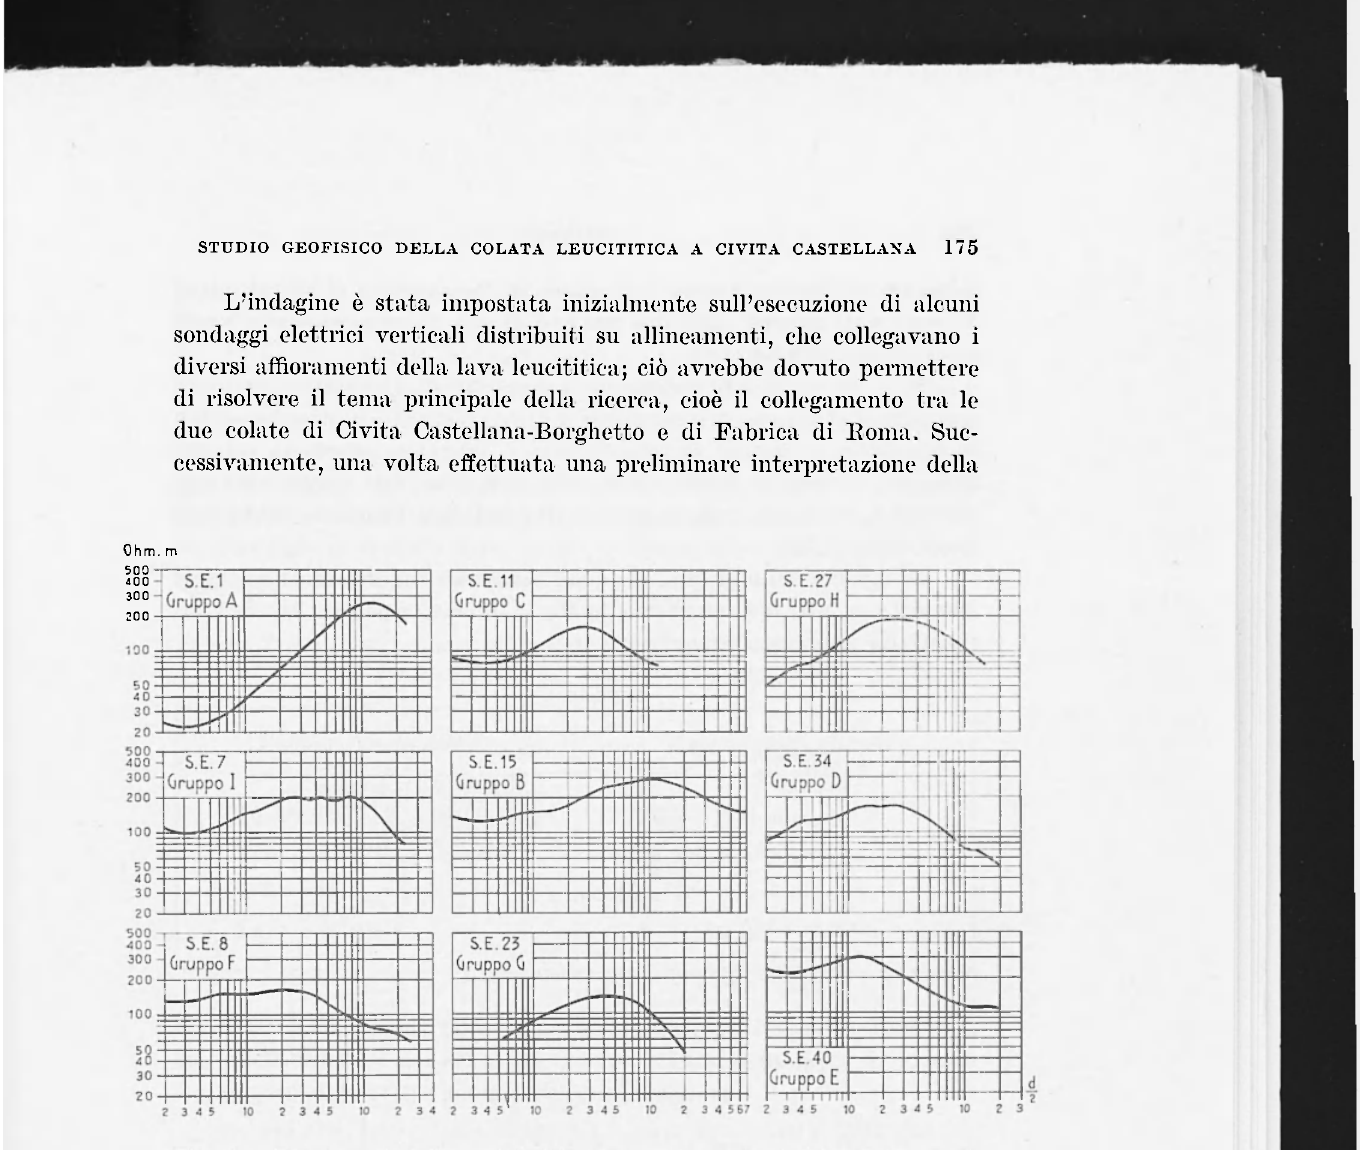
Fig. 2 - Diagrammi delle resistività, apparenti caratteristiche dei gruppi A (S.E. 1), I (S.E. 7), F (S.E. 8), C (S.E. 11), B (S.E. 15), G ( S . E. 23), H (S.E. 27), D (S.E. 34), E (S.E. 40). Le curve 1-8-11 si riferiscono